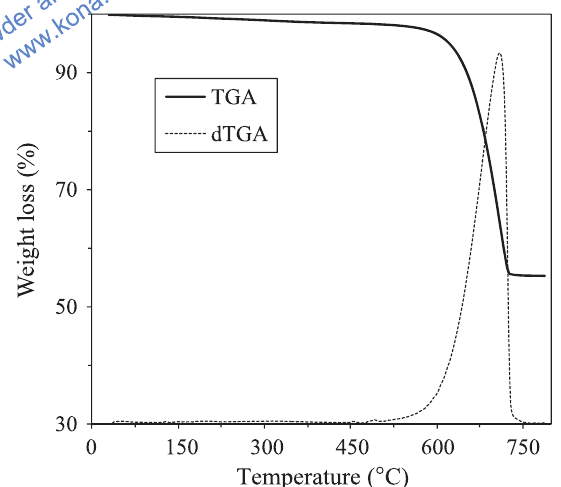
Fig. 5 Thermal stability of CaCO 3 particles measured by TGA (R = 10.8). The maximum weight loss occurs at 710°C as shown in the dTGA curve. The total weight loss is less than 4% at temperatures lower than